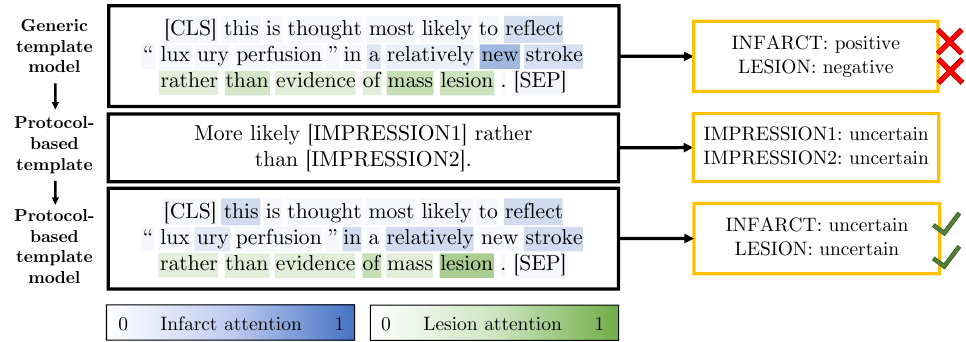
Figure 9. An example sentence from the unlabelled dataset with predictions made by our generic ( top ) and protocol-based ( bottom ) template models. The attention for the infarct and lesion labels is overlaid on the sentences. The protocol-based template shown in the middle row of the figure enables the model to correctly classify these sentences. To simplify the visualisation, the higher-weight attention (either for infarct or lesion) has been overlaid on each